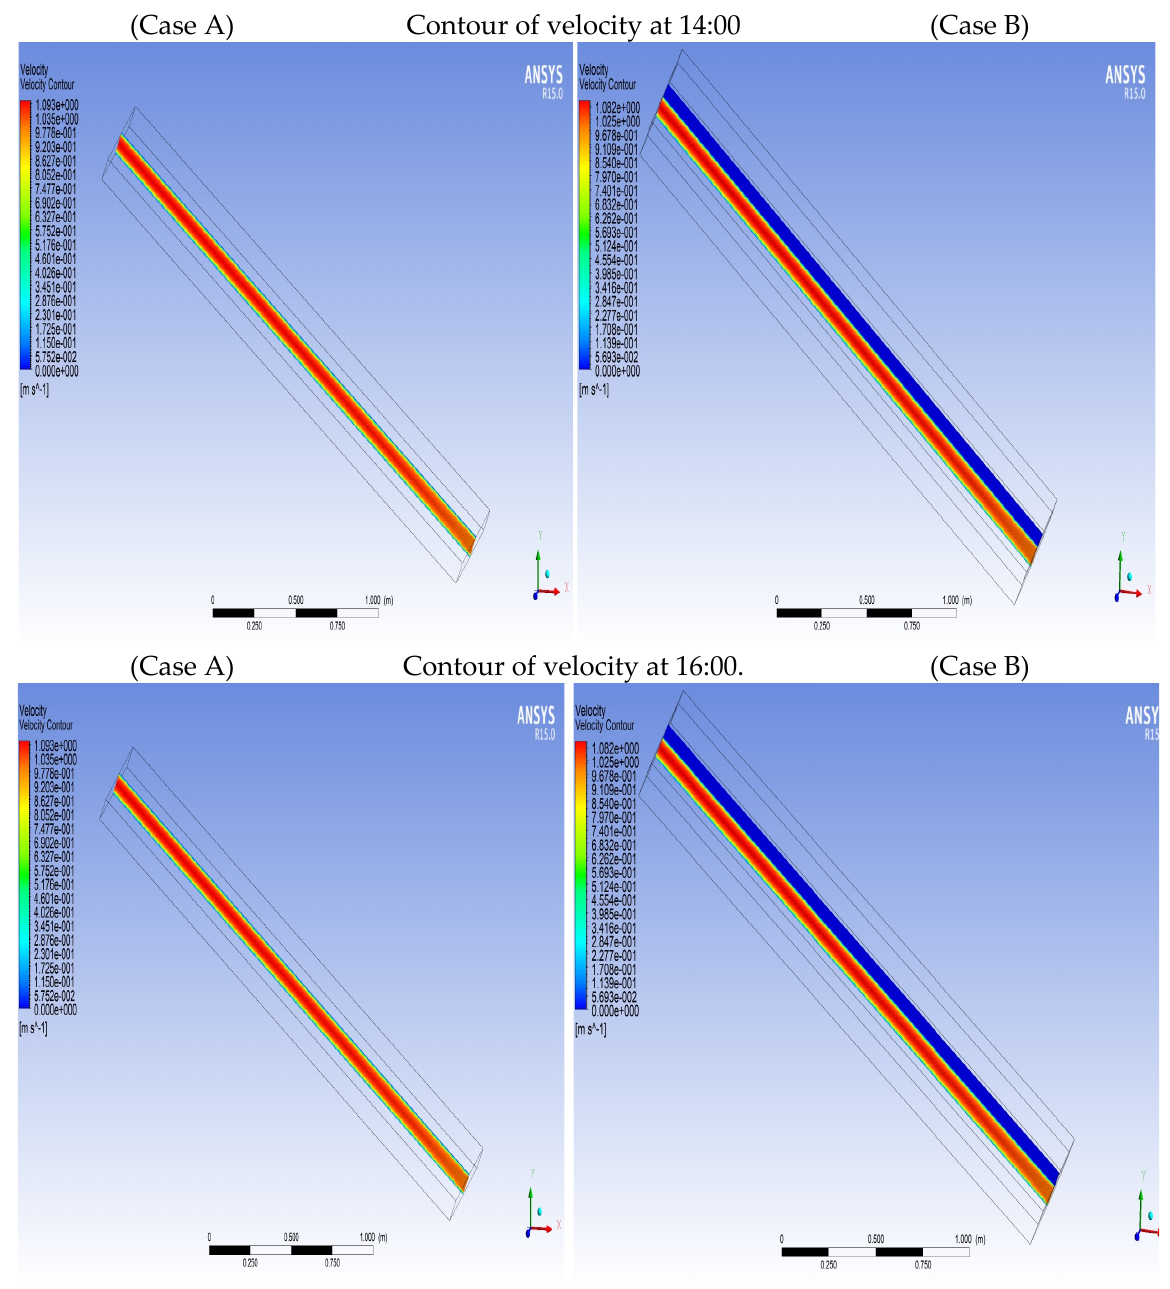
Figure 14. Air fl ow velocity contours for the tested FPSAHs at various time intervals. Figure 14. Airflow velocity contours for the tested FPSAHs at various time